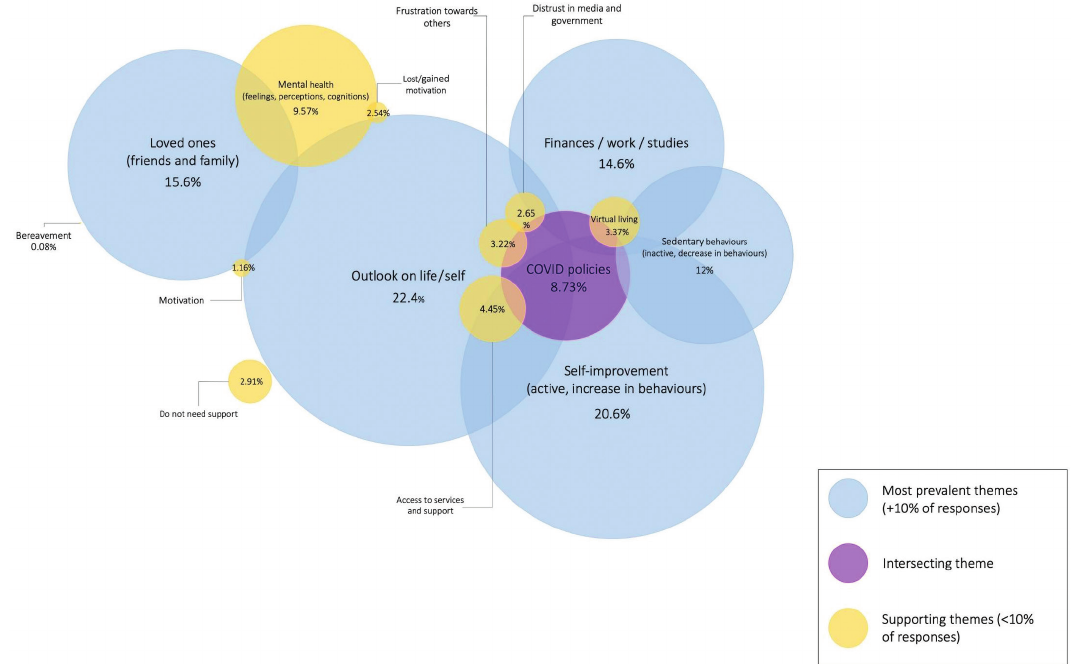
Visual summary showing the relationship between the 13 codes and the extent of overlapping themes across the data set. The size of the circles is relative to their prevalence rates in the dataset, whereby a larger circle represents higher prevalence (e.g., the relative size of the circles was made by setting the length and width of the circles equivalent to their prevalence rate).